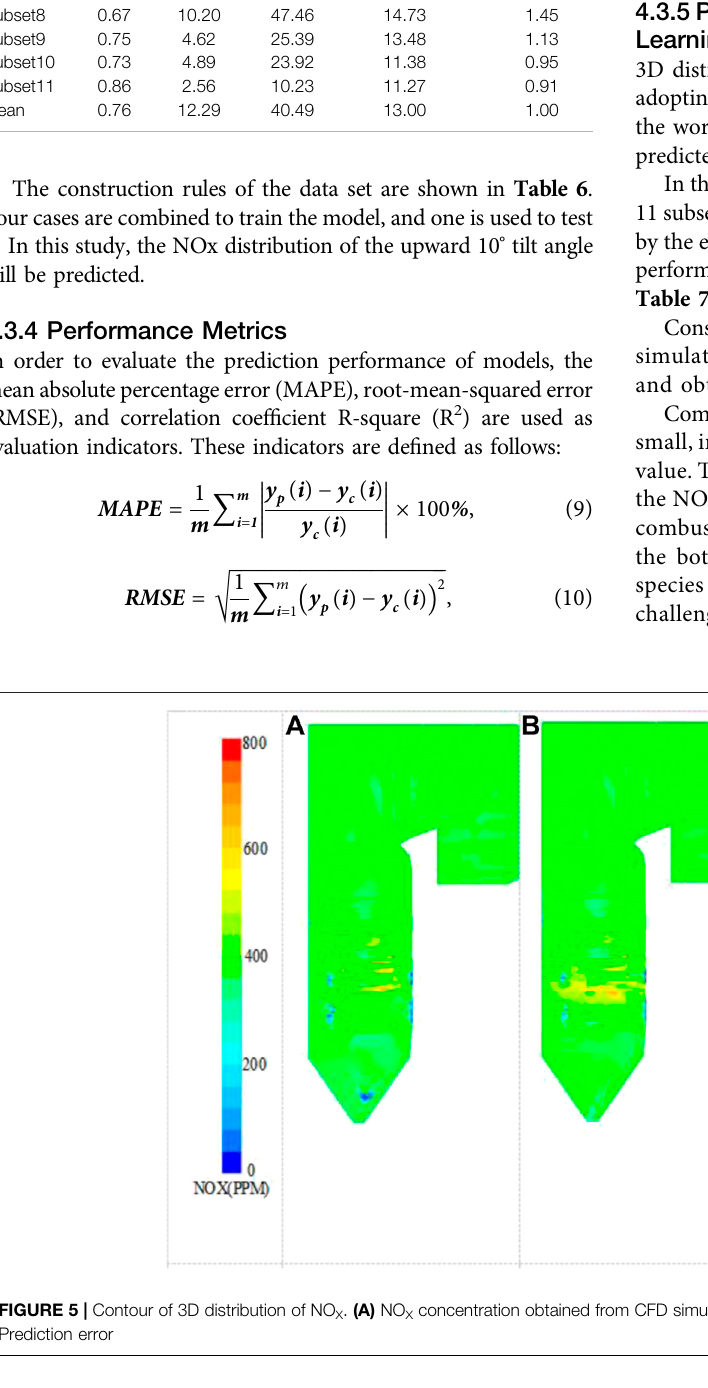
Frontiers in Energy Research |